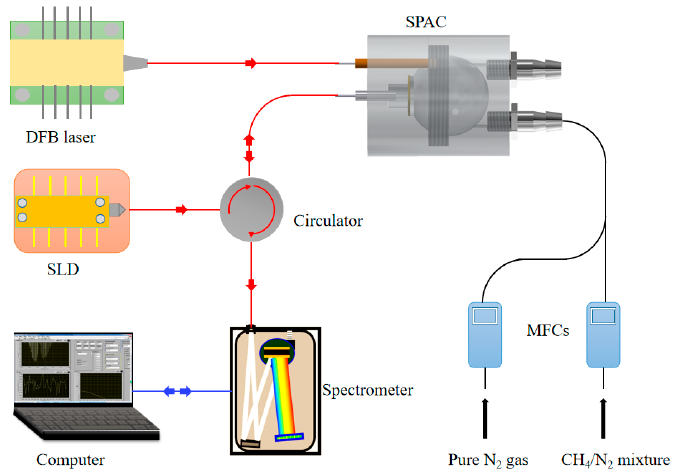
Figure 7. The PAS experimental system based on the SPAC.